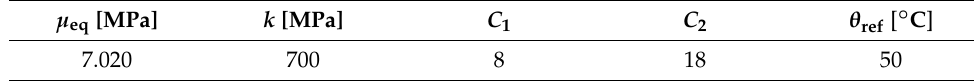
Table 1. Williams-Landel-Ferry (WLF) constants for